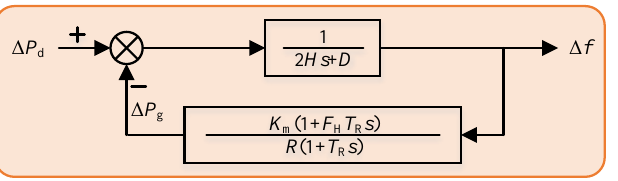
Figure 3. Schematic of the low-order frequency response model of a power